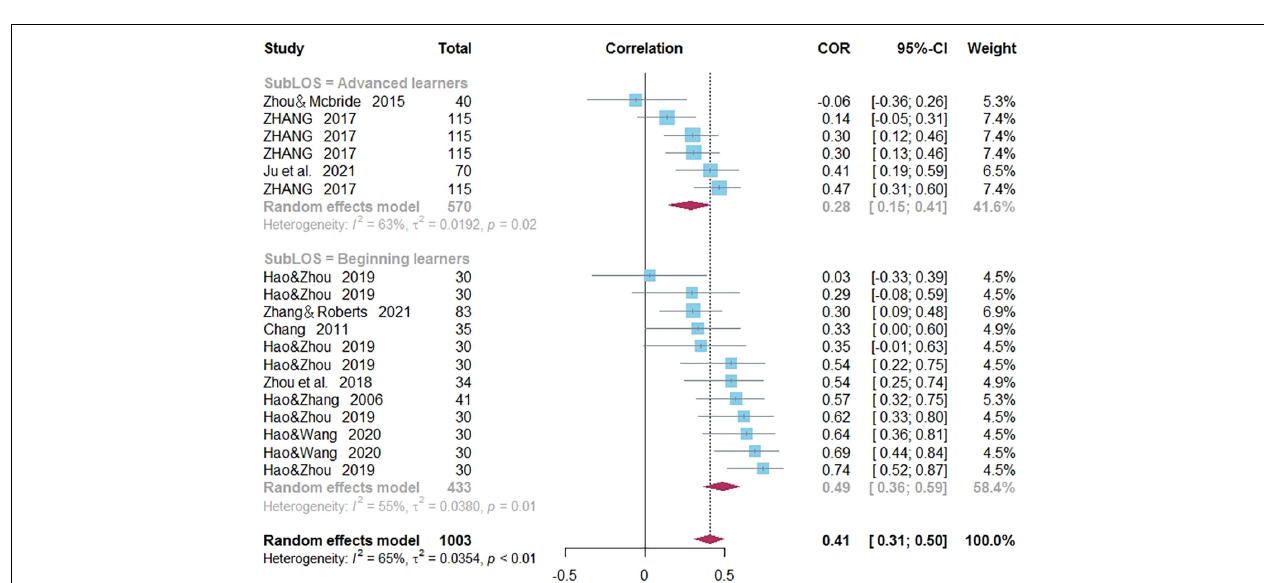
FIGURE 11 | Forest plot for length of study subgroup analysis between phonological awareness and reading.